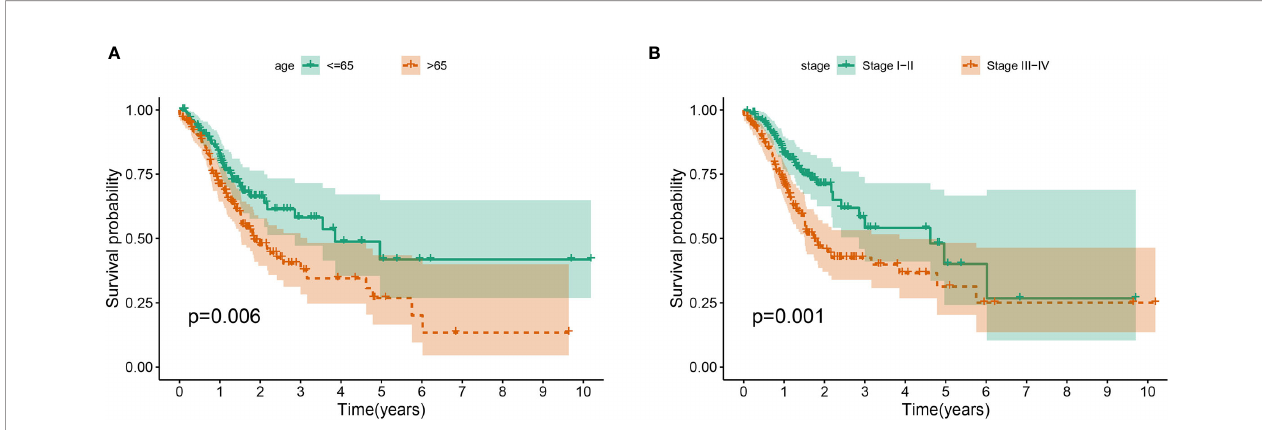
FIGURE 4 | The prognostic value was evaluated based on the age (A) and stage (B) in the complete dataset.